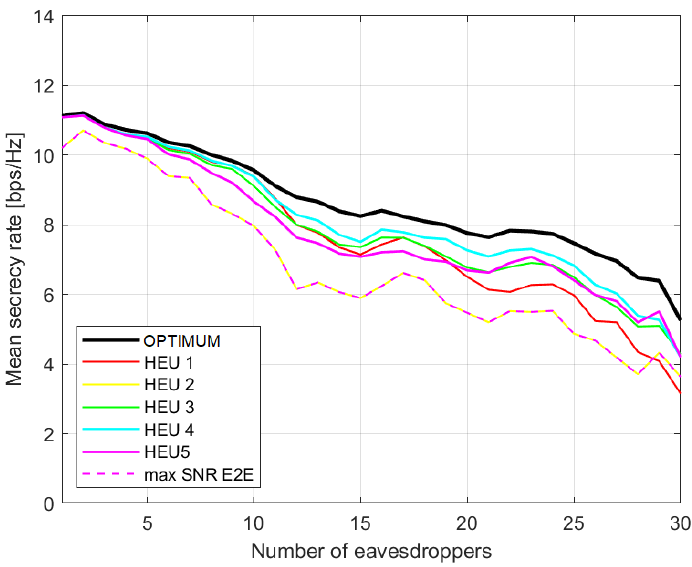
Figure 3. Average secrecy rate with regards to number of eavesdroppers for different approaches. Scenario (nc) with non-cooperative